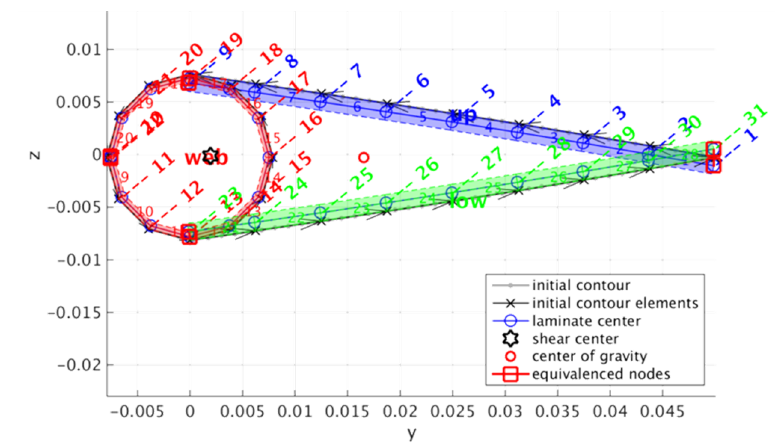
Figure 6. Wing finite element model.